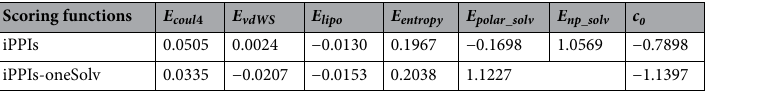
Table 4. Coefficients of the terms obtained for the iPPI-specific scoring functions trained with